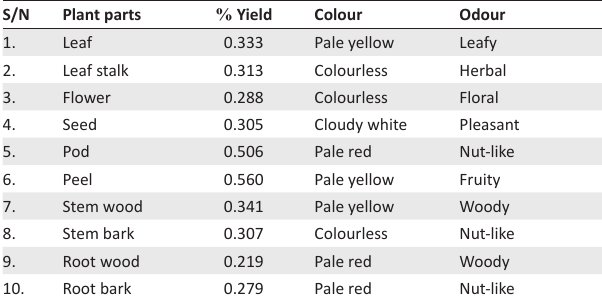
butylated hydroxyl anisole. Note: All the results are mean ± standard deviation (SD) where n = 3. The half maximal inhibitory concentration (IC FIGURE 4: The half maximal inhibitory concentration values (mg/mL) for hydrogen peroxide inhibition of Calophyllum TABLE 1: Percentage ( % ) yield of 10 essential oils from Calophyllum inophyllum LINN.